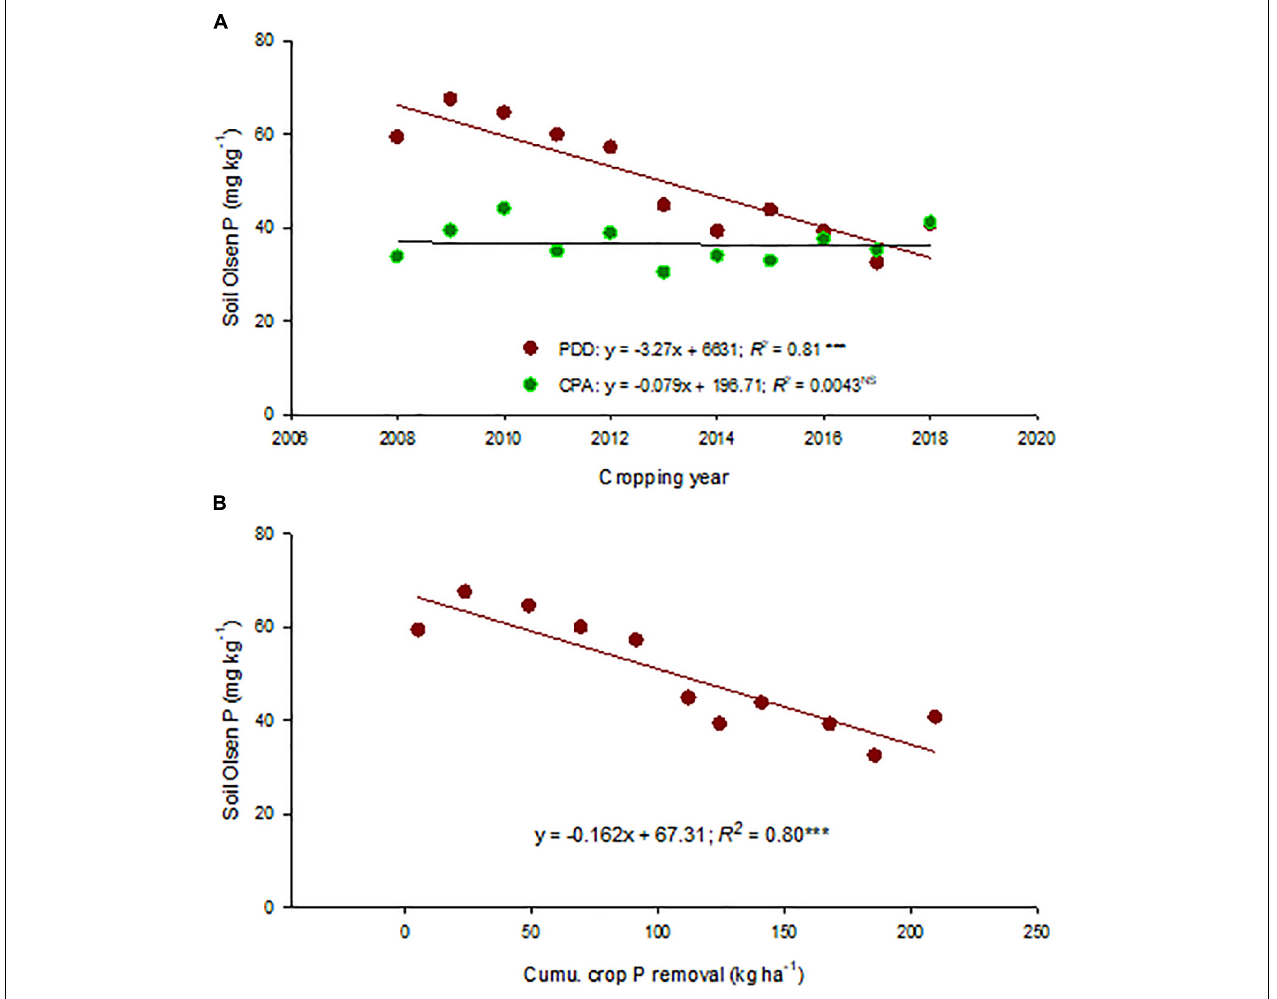
FIGURE 4 | (A) Temporal changes of the soil Olsen P concentration in the 0- to 15-cm soil layer with continuous fertilizer P addition ( CPA ) and soil P draw-down ( PDD ). (B) Relationship between cumulative crop P removal and soil Olsen P concentration (0–15 cm) under PDD. ***Significant at the P ≤ 0.01 level. NS , not significant at the P ≤ 0.05